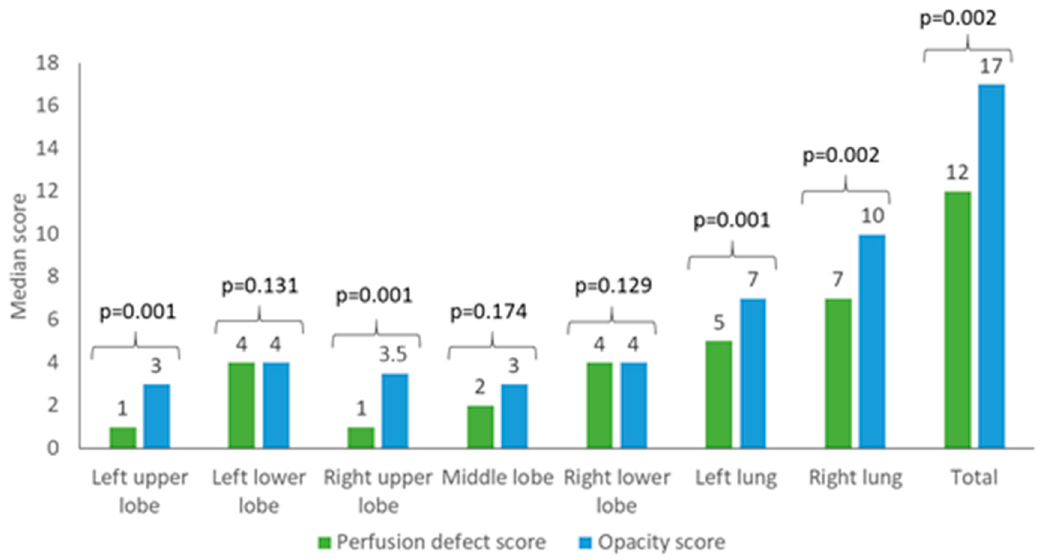
Figure 4. Median perfusion defect scores of reader 1 are displayed in green. Automatic opacity score is shown in